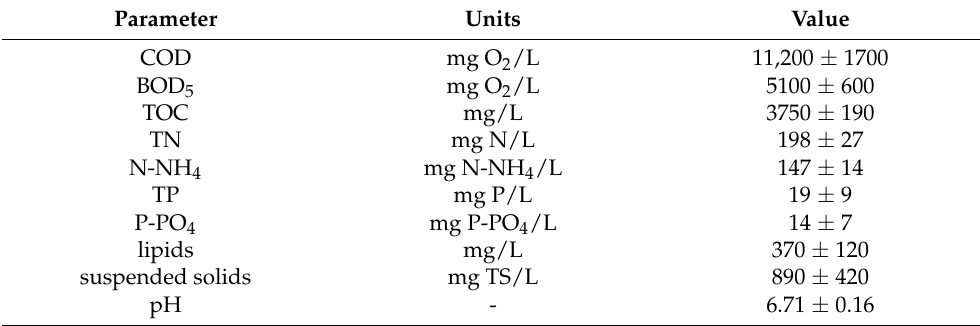
Table 1. Characteristics of confectionery wastewater used in the study ( ± std. dev., n = 96).